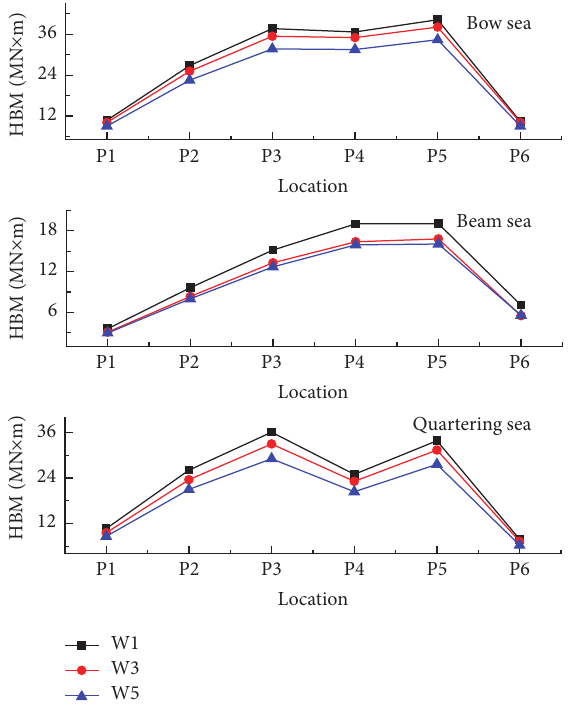
Figure 27: Longitudinal distribution of HBM.